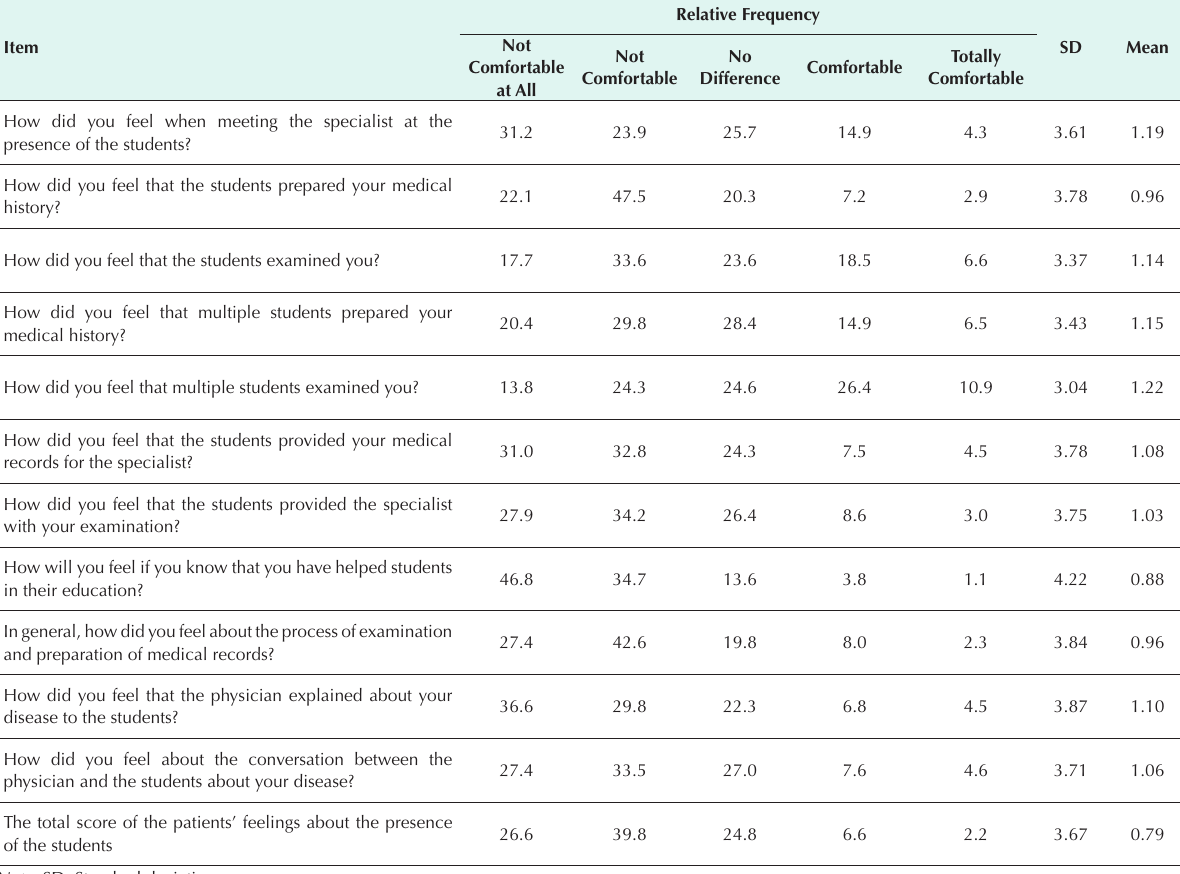
Table 2. Mean and SD of the Items Related to Patients’ Feelings to the Presence of the Students